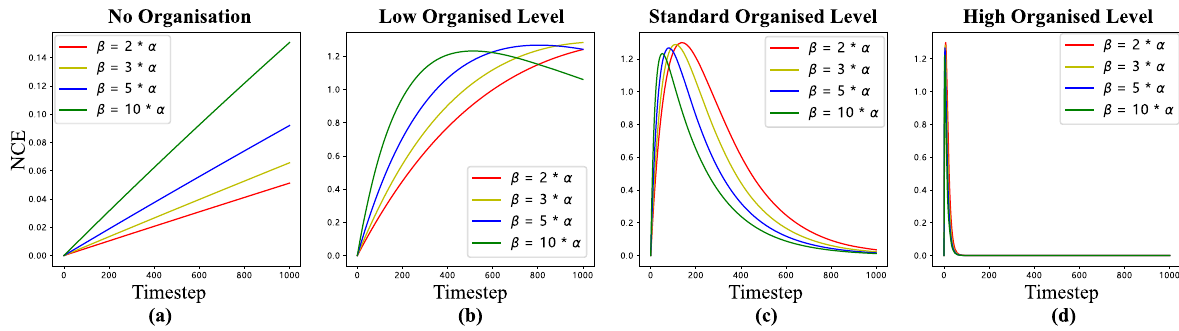
Fig. 3 Visualisations of the double-exponential model with different values of α and β . a No organisation: 1 α > 1 β > n . b Low organisational level: 1 α > n > 1 β